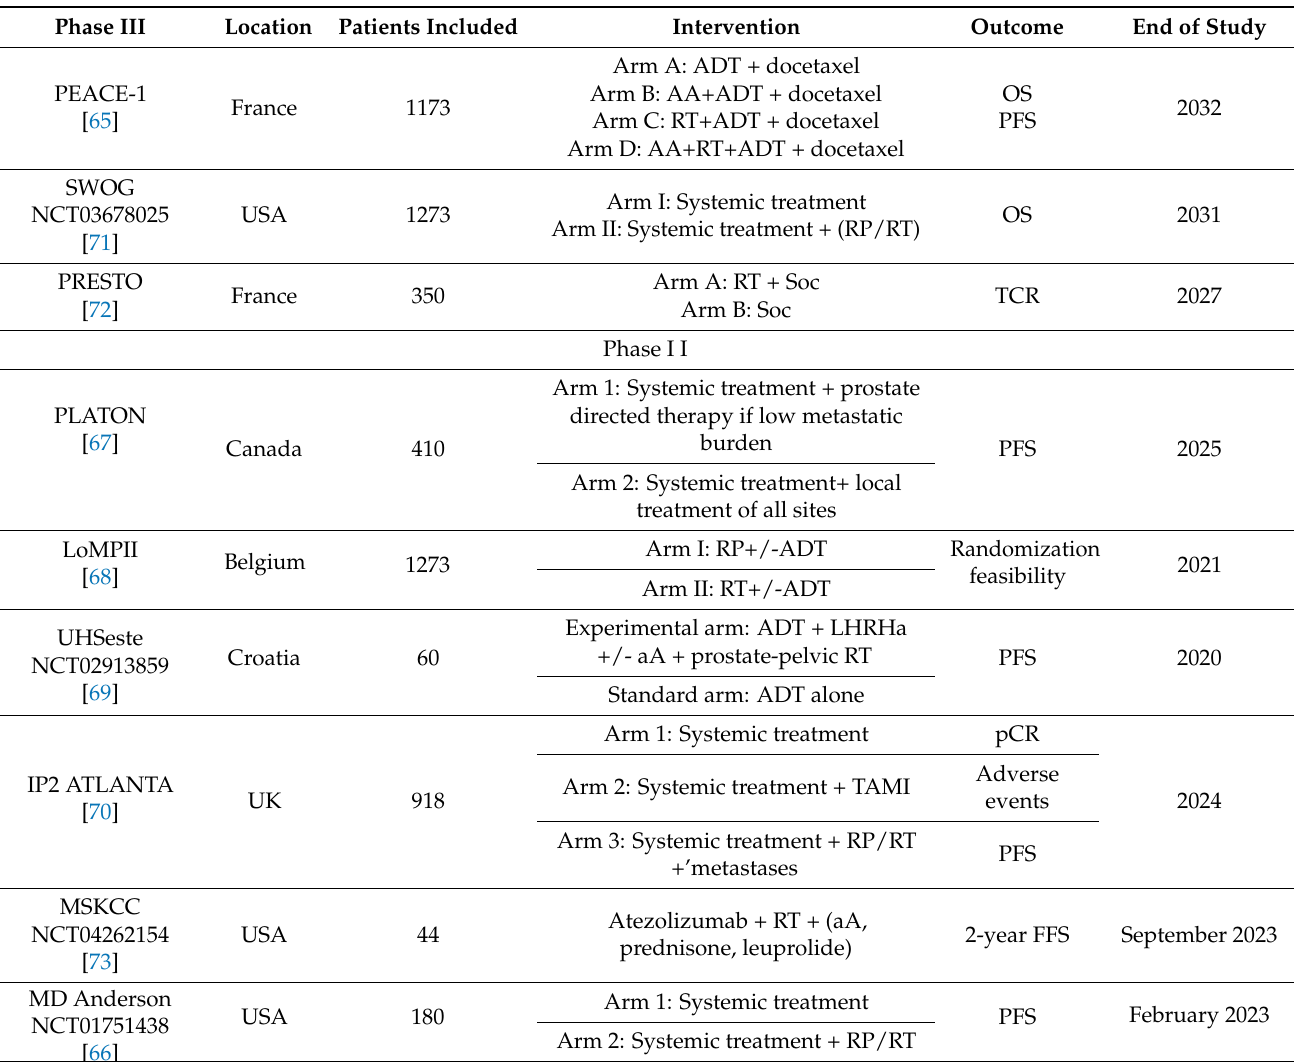
Table 4. Ongoing trials for metastatic prostate cancer.